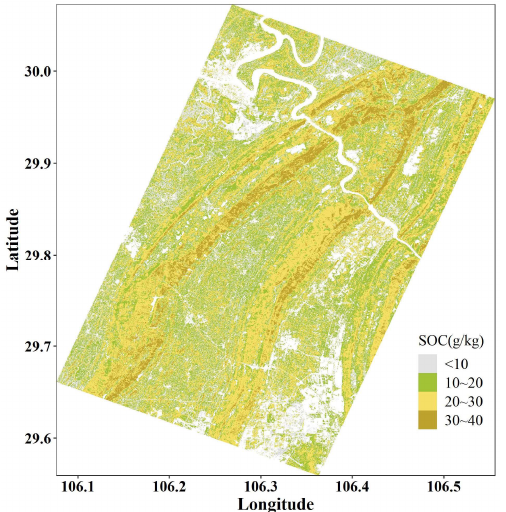
Figure 4. SOC content mapping based on the RF and XGBoost models.